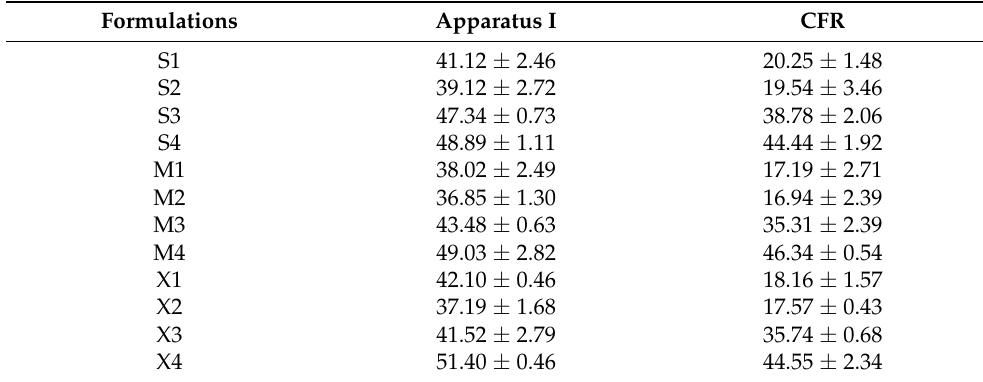
Table 6. DE of CHD release using Apparatus I and CFR methods. Data are expressed as mean percentages ± SD, n =